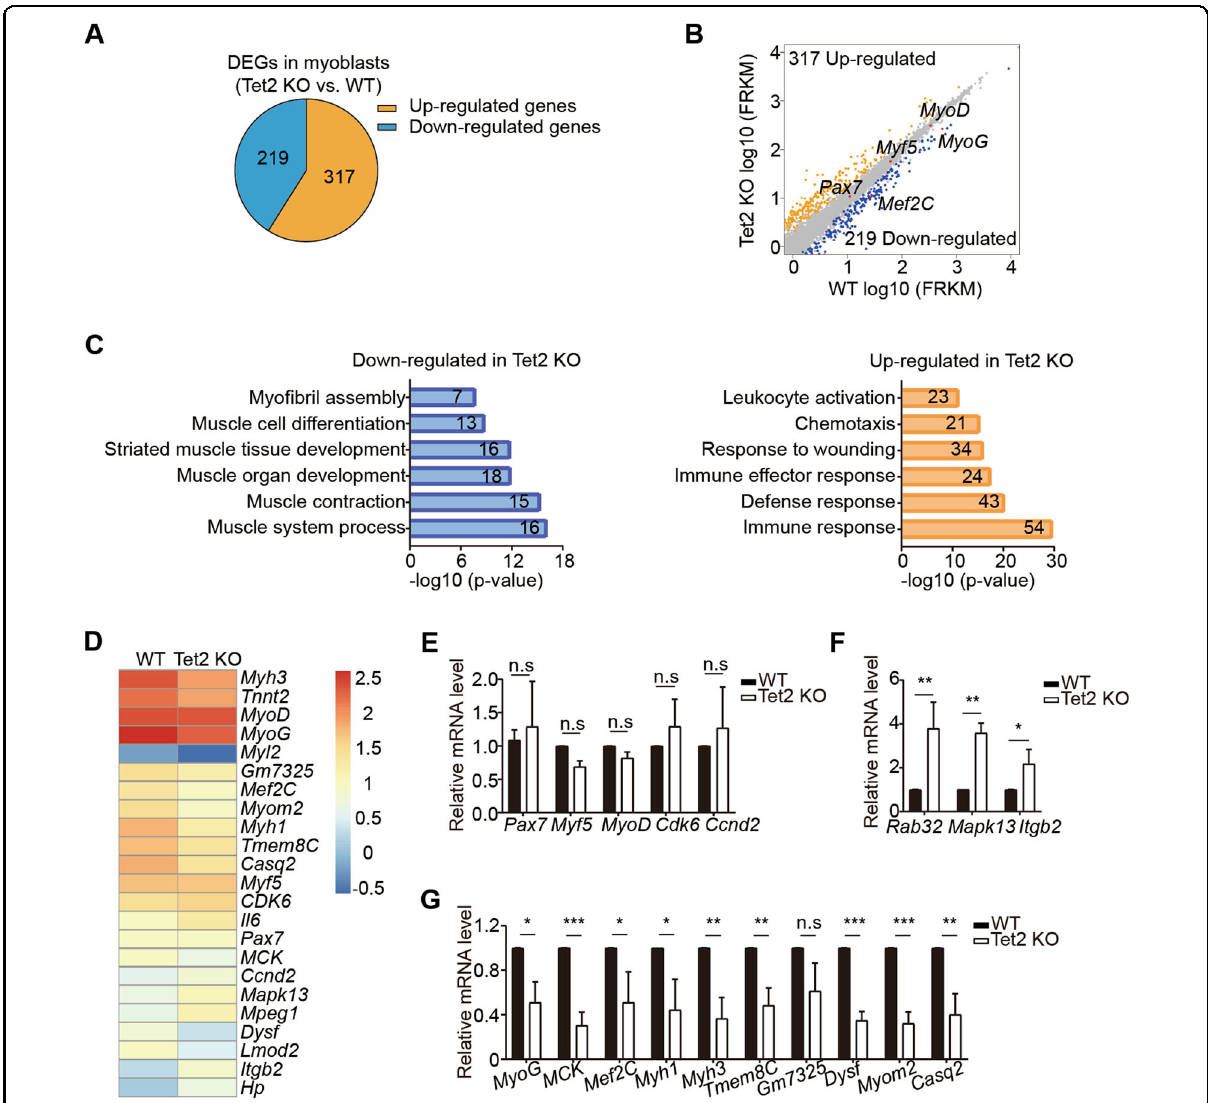
Fig. 3 RNA-sequencing analysis of Tet2 KO myoblasts. A Pie chart indicated the differentially expressed genes (DEGs) of Tet2 KO myoblasts compared to those of WT myoblasts. B Scatter plot indicated the DEGs of Tet2 KO myoblasts compared to those of WT myoblasts. C Gene ontology analysis of DEGs in Tet2 KO myoblasts. Numbers within bars indicated the number of genes identi fi ed within the corresponding gene ontology categories. D Heat map of the expression level of representative genes in myogenesis. E Expression levels of the fate determination and proliferation related genes in Tet2 KO myoblasts ( n = 3). F Expression levels of the upregulated genes in Tet2 KO myoblasts ( n = 3). G Expression levels of the differentiation related genes in Tet2 KO myoblasts ( n = 3). * p < 0.05, ** p < 0.01, *** p <